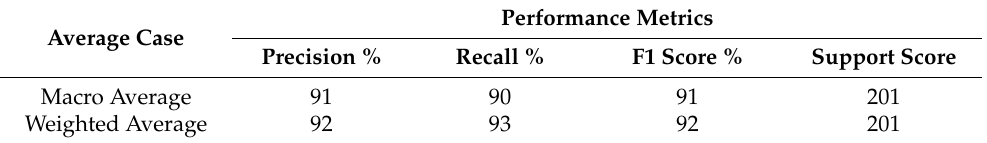
Table 11. The BiGR classification report analysis by the average